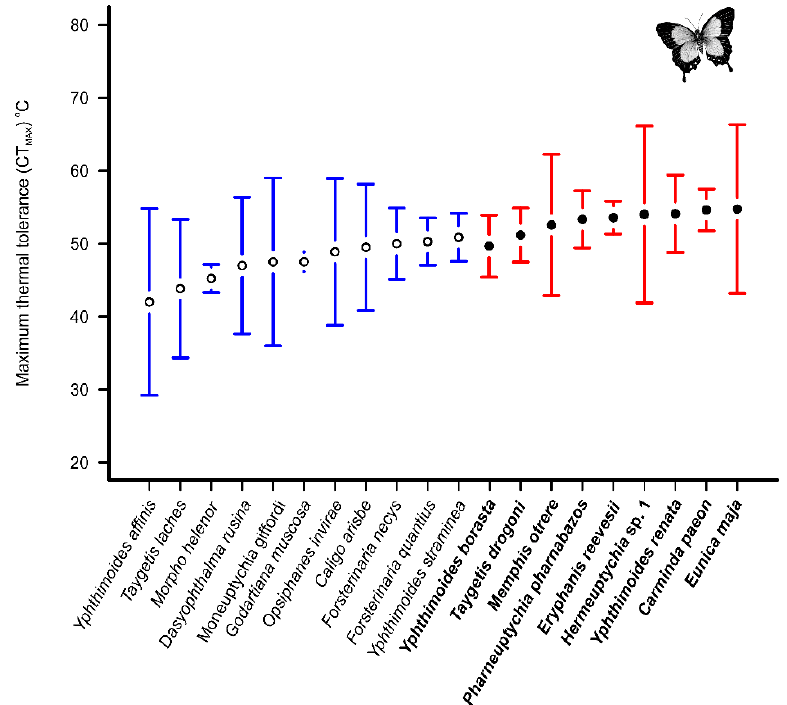
Figure 3. Mean of maximum critical temperature (CTmax) of the fruit-feeding butterflies sampled in each mountaintop environment: forest islands versus campo rupestre. Only species with more than three specimens were used in this analysis. The bars represent 95% confidence interval.